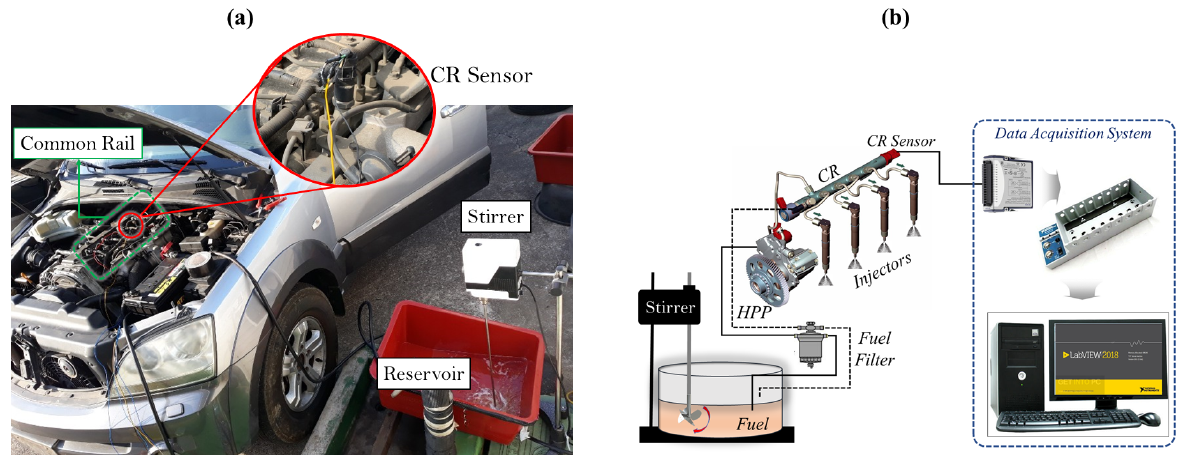
Figure 2. A view of ( a ) the actual experiment setup, ( b ) schematic view of the experimental setup. From the car engine’s rail pressure sensor (RPS), pressure measurements were digitally collected via an NI 9228 at 200 Hz on a NI Compact DAQ 9178 data acquisition system a response time ( τ 10/90 ) ≤ 5 mSecs and a maximum overpressure of 1800 bar (rupture